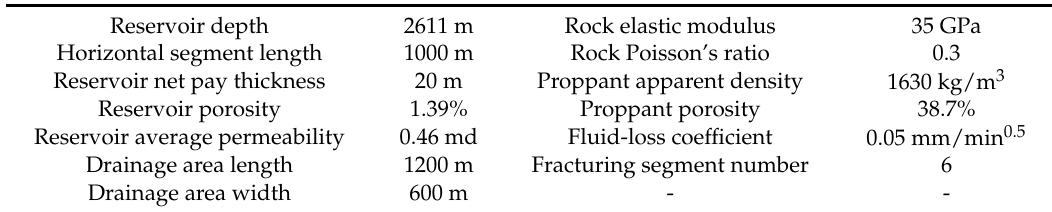
Table 1. Reservoir properties and fixed fracturing parameters.